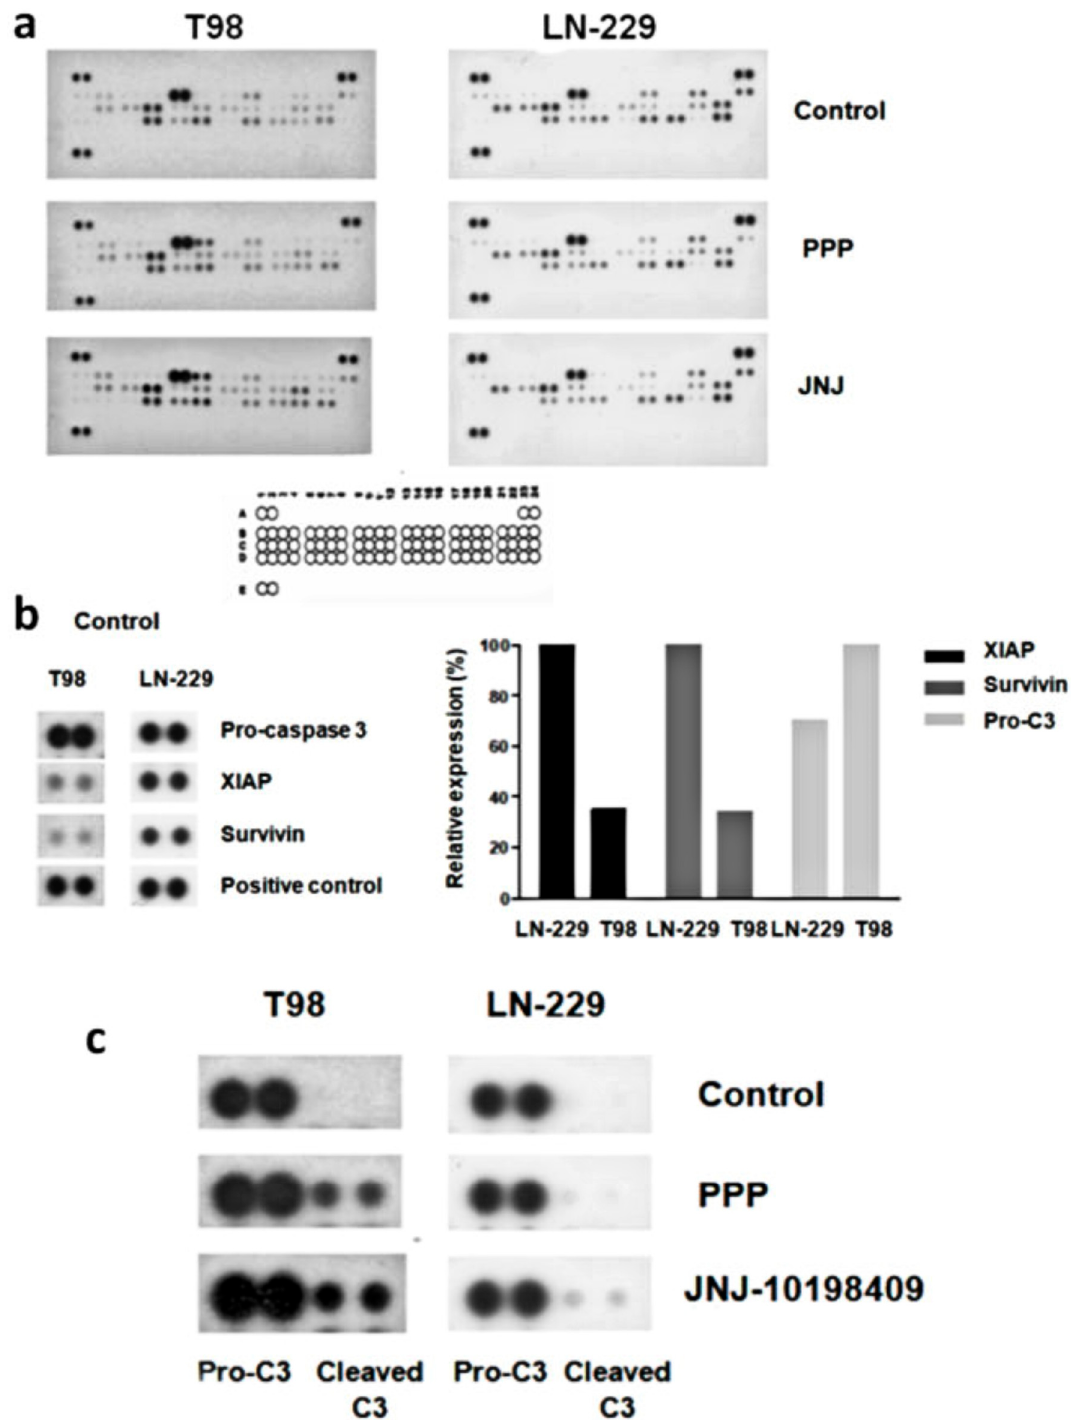
Figure 7. JNJ and PPP effects on the apoptotic proteome of GBM cells indicated by apoptosis arrays. ( a ) Effects on levels and phosphorylation status of 35 proteins related to apoptosis. T98 and LN-229 cells were treated with DMSO (Control), 500 nM PPP or 500 nM JNJ for 24 h and subjected to apoptosis arrays, as described in Materials and Methods. Legend: A1, A2, A23, A24, E1 and E2: Positive controls. B1 and B2: Bad. B3 and B4: Bax. B5 and B6: Bcl-2. B7 and B8: Bcl-x. B9 and B10: Pro-Caspase-3. B11 and B12: Processed caspase-3. B13 y B14: Catalase. B15 and B16: c-IAP-1. B17 and B18: c-IAP-2. B19 and B20: Claspin. B21 and B22: Clusterin. B23 and B24: Cytochrome c. C1 and C2: TRAIL R1/DR4. C3 and C4: TRAIL R2/DR5. C5 and C6: FADD. C7 and C8: Fas/TNFRSF6. C9 and C10: HIF-1 α . C11 and C12: HO-1/HSP32. C13 and C14: HO-2. C15 and C16: HSP27. C17 and C18: HSP60. C19 and